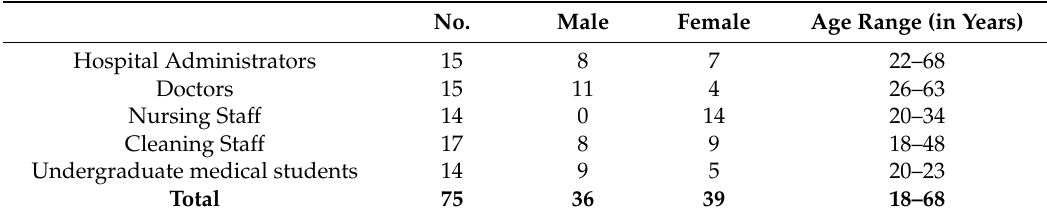
Table 1. Characteristics of